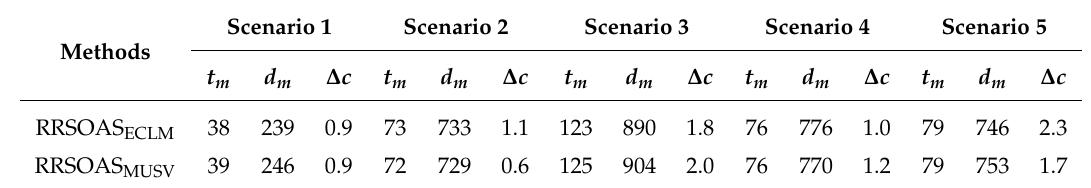
Table 2. Indicators (55) achieved by RRSOAS algorithm with each prediction model in the scenarios proposed in [31]. These indicators characterize the paths shown in Figure 12.